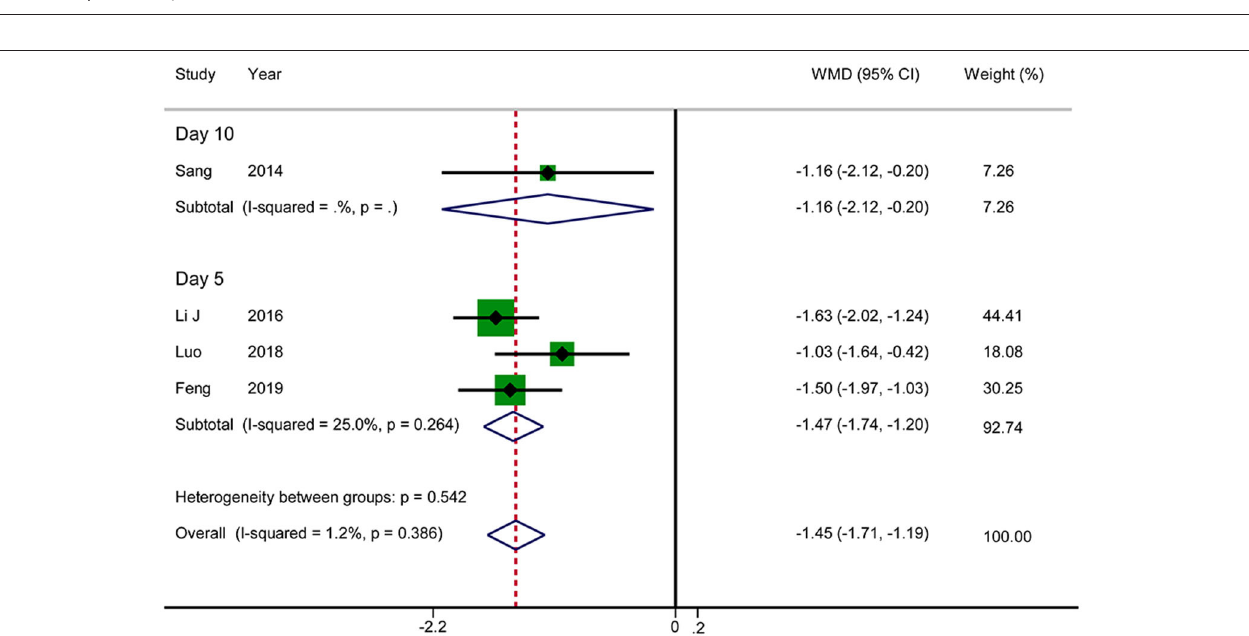
FIGURE 4 | Meta-analysis of VAS score for abdominal